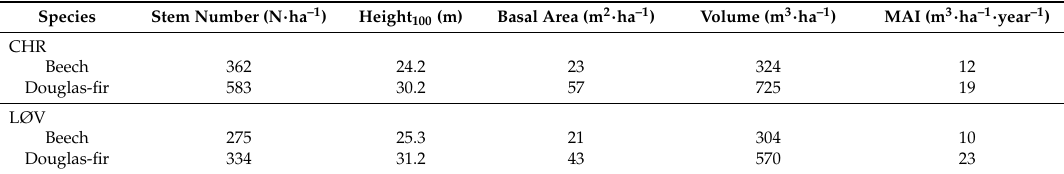
Table 2. Stand data from 2013 for the investigated